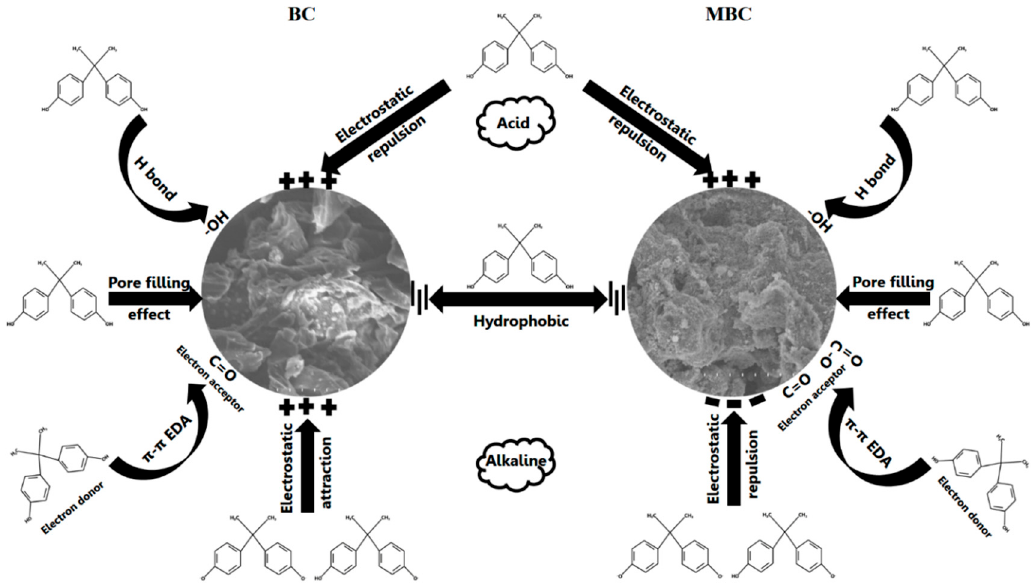
Figure 7. Mechanism of adsorption of BPA by BC and MBC.